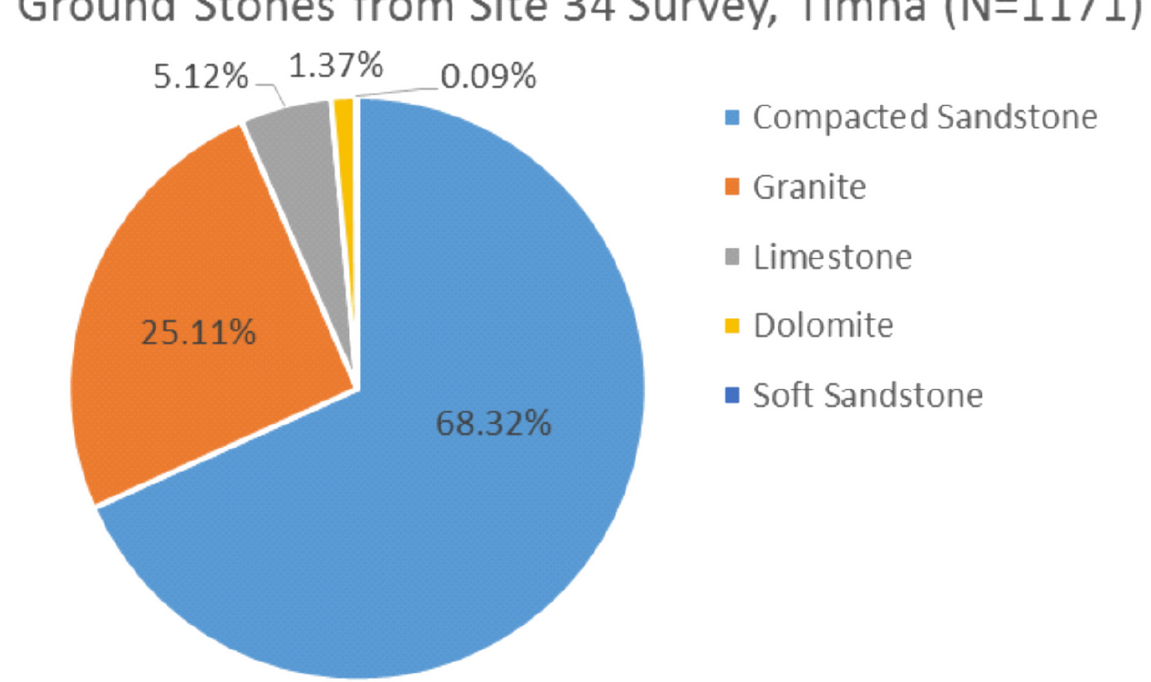
Figure 17. Distribution of ground stone rock types from the Site 34